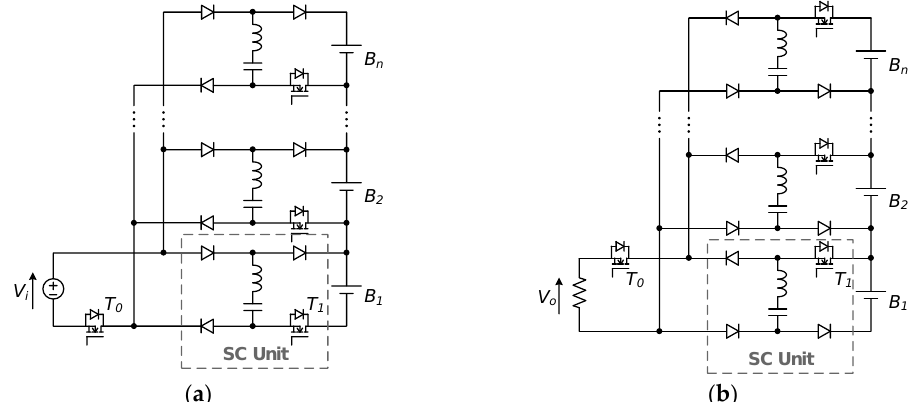
Figure 1. Generalized topology of the multi-port switched-capacitor (SC) converter; ( a ) Single-Input Multi-Output (SIMO) configuration; ( b ) Multi-Input Single-Output (MISO) configuration.